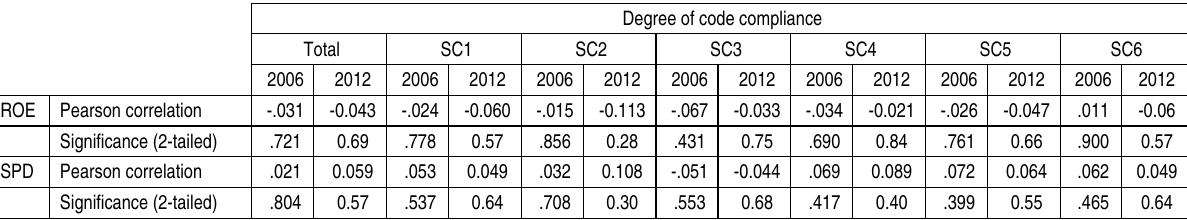
Table 5. Impact of compliance on operating performance and stock price